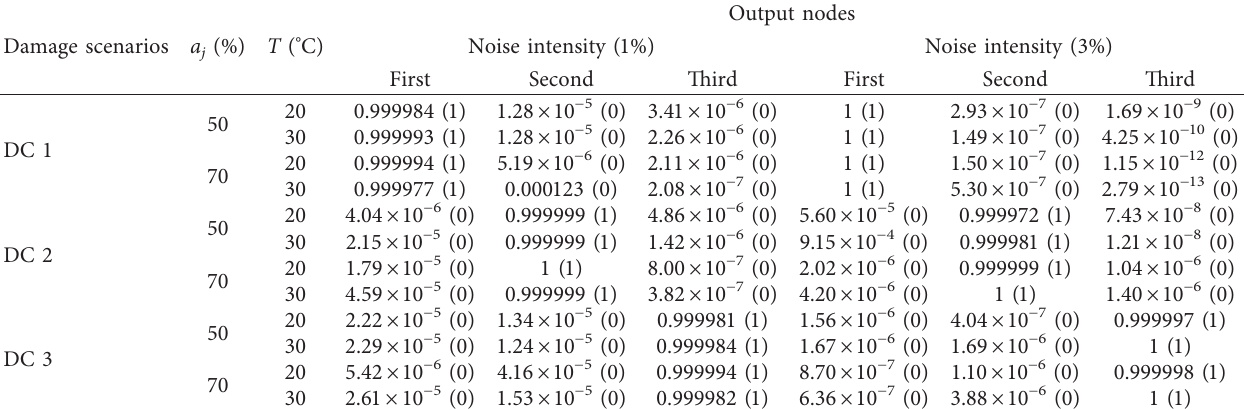
The target results of networks are shown in the